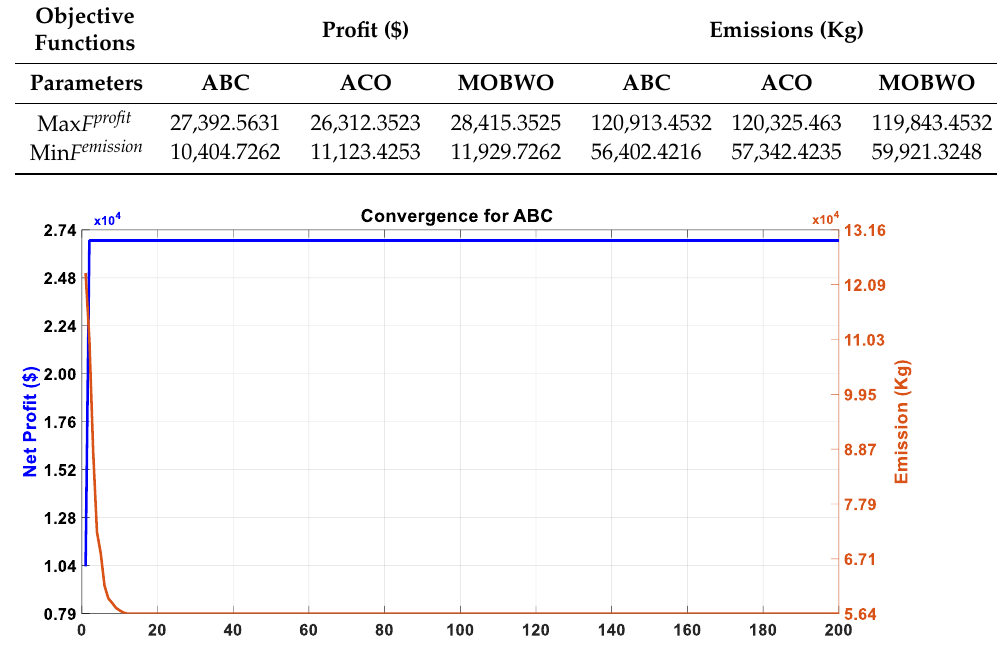
Table 11. The pay-off table for the proposed MOBWO (15-min scheduling).